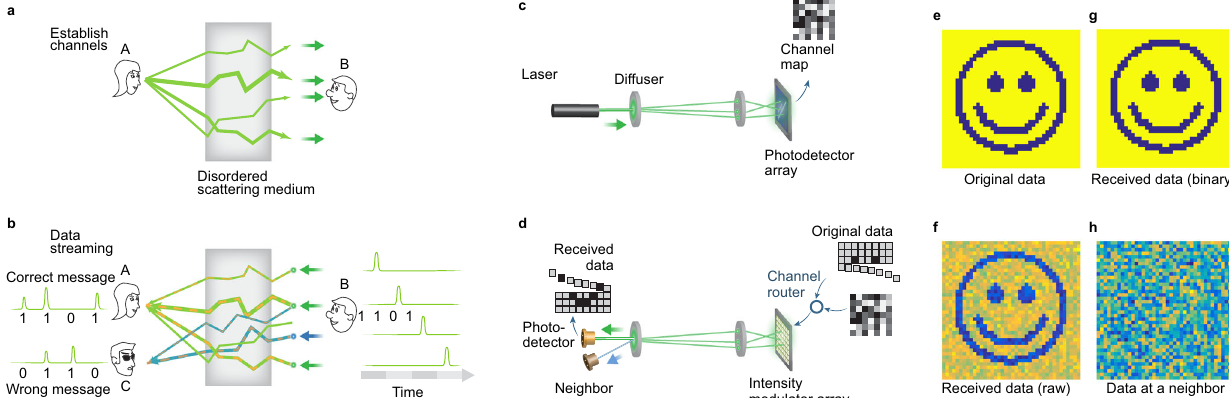
Fig. 5 Secure communication with OCIS. a , b Conceptual illustration. OCIS enables secure free-space optical communications between communication parties Alice and Bob. a Alice establishes optical channels between Alice and Bob by sending a laser pulse through the scattering medium. Bob measures the resultant speckle intensity pattern on the remote end to reveal the optical channels between Alice and Bob. b To send a binary message to Alice, Bob streams spatially incoherent optical pulses through different channels of the scattering medium, e.g., logical ones to randomly selected bright channels and logical zeros to randomly selected dark channels. As a result, Alice receives a matched message, while a third person Chuck receives a random message because the channels between Bob and Chuck are uncorrelated with those between Alice and Bob. c , d Experimental demonstration of the OCIS-based free-space secure communication. c A laser beam transmits through a local and a remote diffuser. A photodetector array at the remote end measures the resultant speckle pattern as the map of the optical channels. d An intensity modulator array is used to route the optical pulses to different channels based on the message and the measured channel map. Two photodetectors on the local side record the returned optical pulses. One of the photodetectors is conjugated to the laser, while the other one is placed elsewhere. e – h Experimental results. e Original binary data. f Raw data received by the conjugated photodetector. g Binarized data of ( f ). h Raw data received by the neighboring